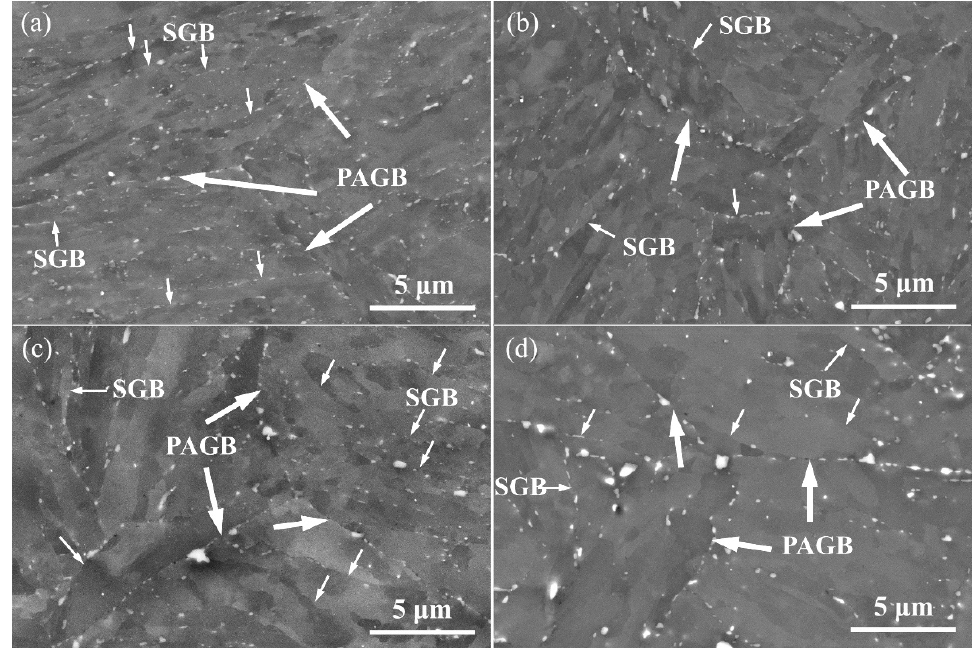
Figure 3. SEM images illustrating the coarsening of M 23 C 6 precipitates with the increase in duration at 675 °C for P91 steels, including ( a ) 0 h, ( b ) 1000 h, ( c ) 4000 h, and ( d ) 16,000 h. The bright particles are M 23 C 6 precipitates. The wide arrows mark the prior austenite grain boundaries (PAGBs) and the narrow arrows denote the sub-grain boundaries (SGBs). Most M 23 C 6 precipitates are located at these boundaries.